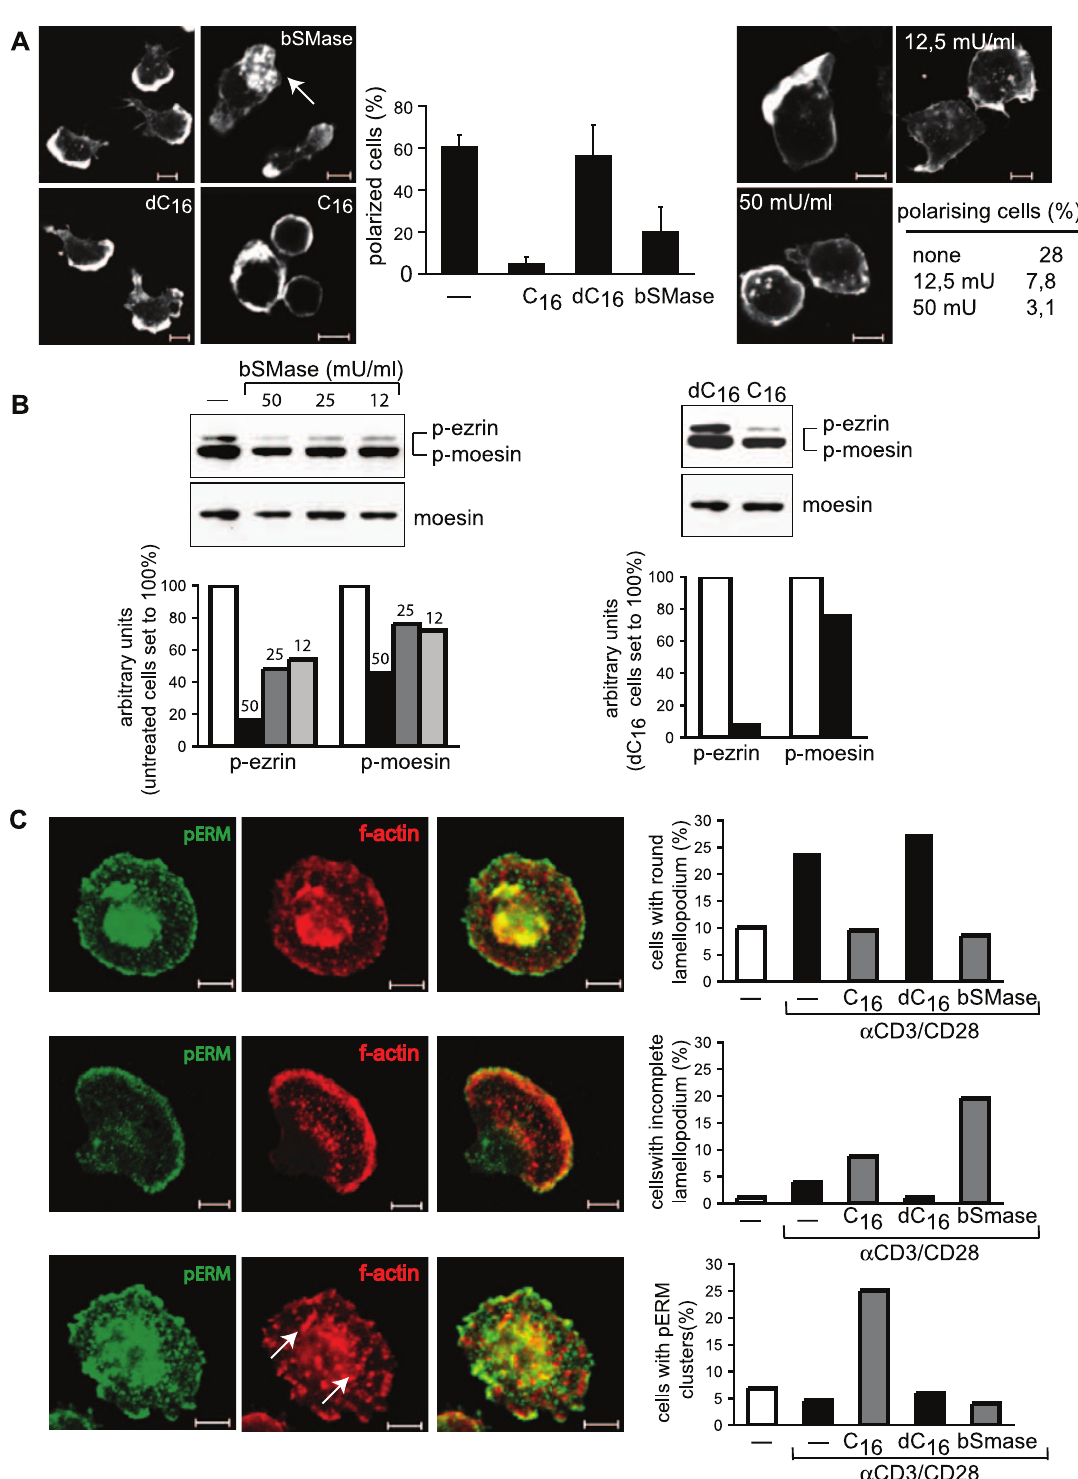
Figure 4. Ceramide generation abolishes T cell polarisation and spreading as well as pERM levels. Human T cells (left untreated or exposed to bSMase, C 16 or dC 16 were seeded onto (A) FN (left and middle panel; right panel shows Jurkat cells 30 min after FN seeding) or (C) a CD3/CD28 coated slides, and stained, in (A), for f-actin alone or in (C), together with pERM protein. F-actin aggregates consistent with formation of podosome-like structures are exemplified by arrows. The percentages of cells acquiring a polarised phenotype in (A) (middle and right panel) or in (C), differing in morphologyby developing organised round orincomplete lamellopodiaor revealingpERM clustersandpodosome-like structures (arrows) areindicated (at least each 100 cells were counted per culture). Scale bars represent 5 m m. (B) Levels of p-ezrin/moesin were determined in primary human T cells left untreated or exposed to bSMase at theconcentrationsindicated (left panel) or exposed to dC 16 or C 16 (50 m m) (right panel), each for2 hrs by WB. p-ezrin or p-moesin levels were quantified by densitometry (bottom graphs). Detection of moesin served as loading control.